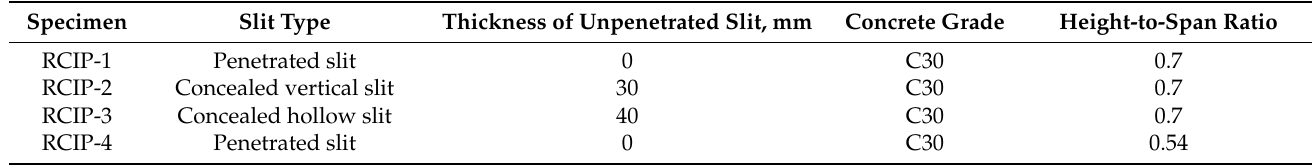
Table 1. Details of the test